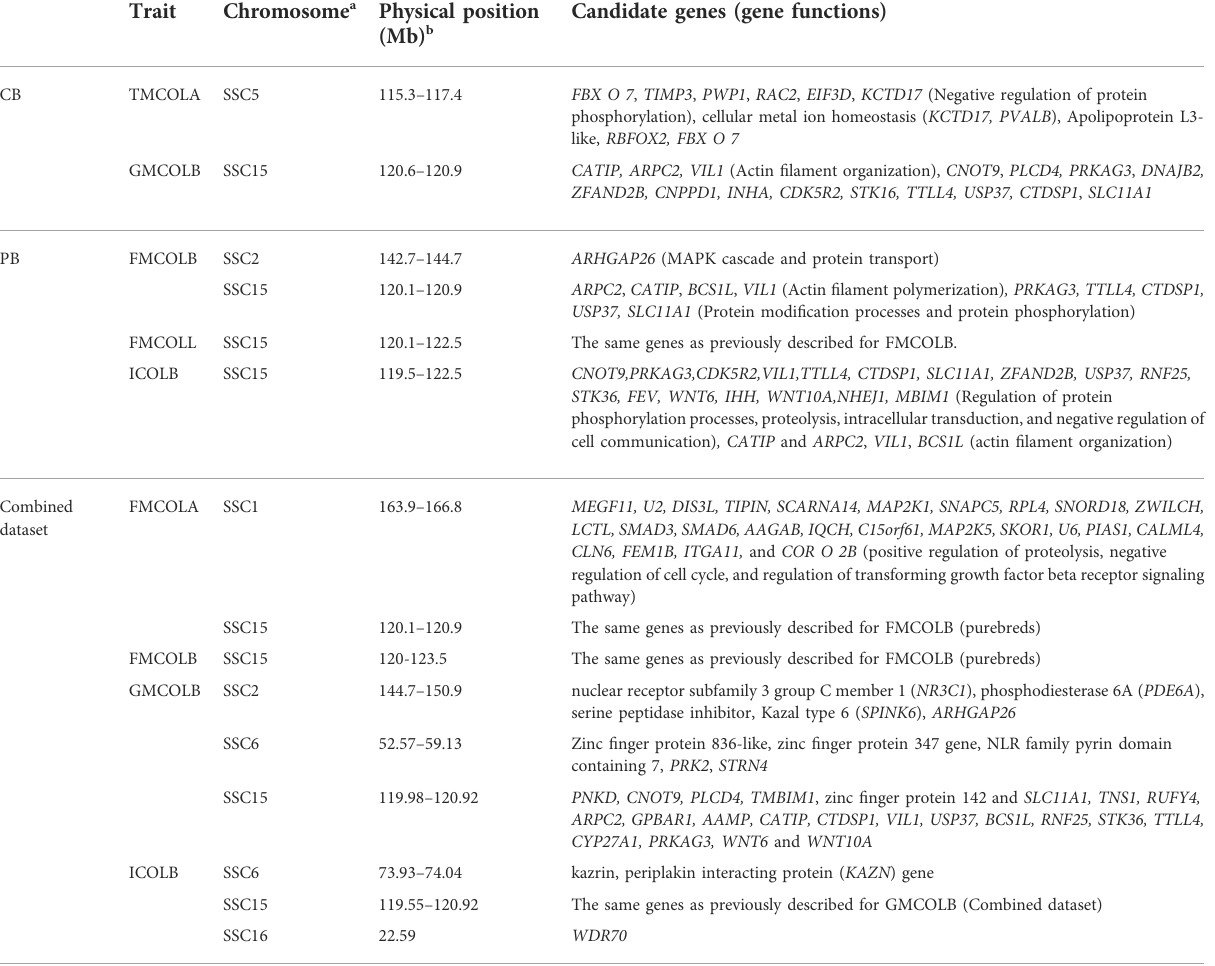
TABLE 9 Candidate genes located on signi fi cant regions and/or nearby regions identi fi ed by whole-genome sequence (WGS) for meat color traits in different populations (crossbreds (CBs), purebreds (PBs), combined CBs and PBs).